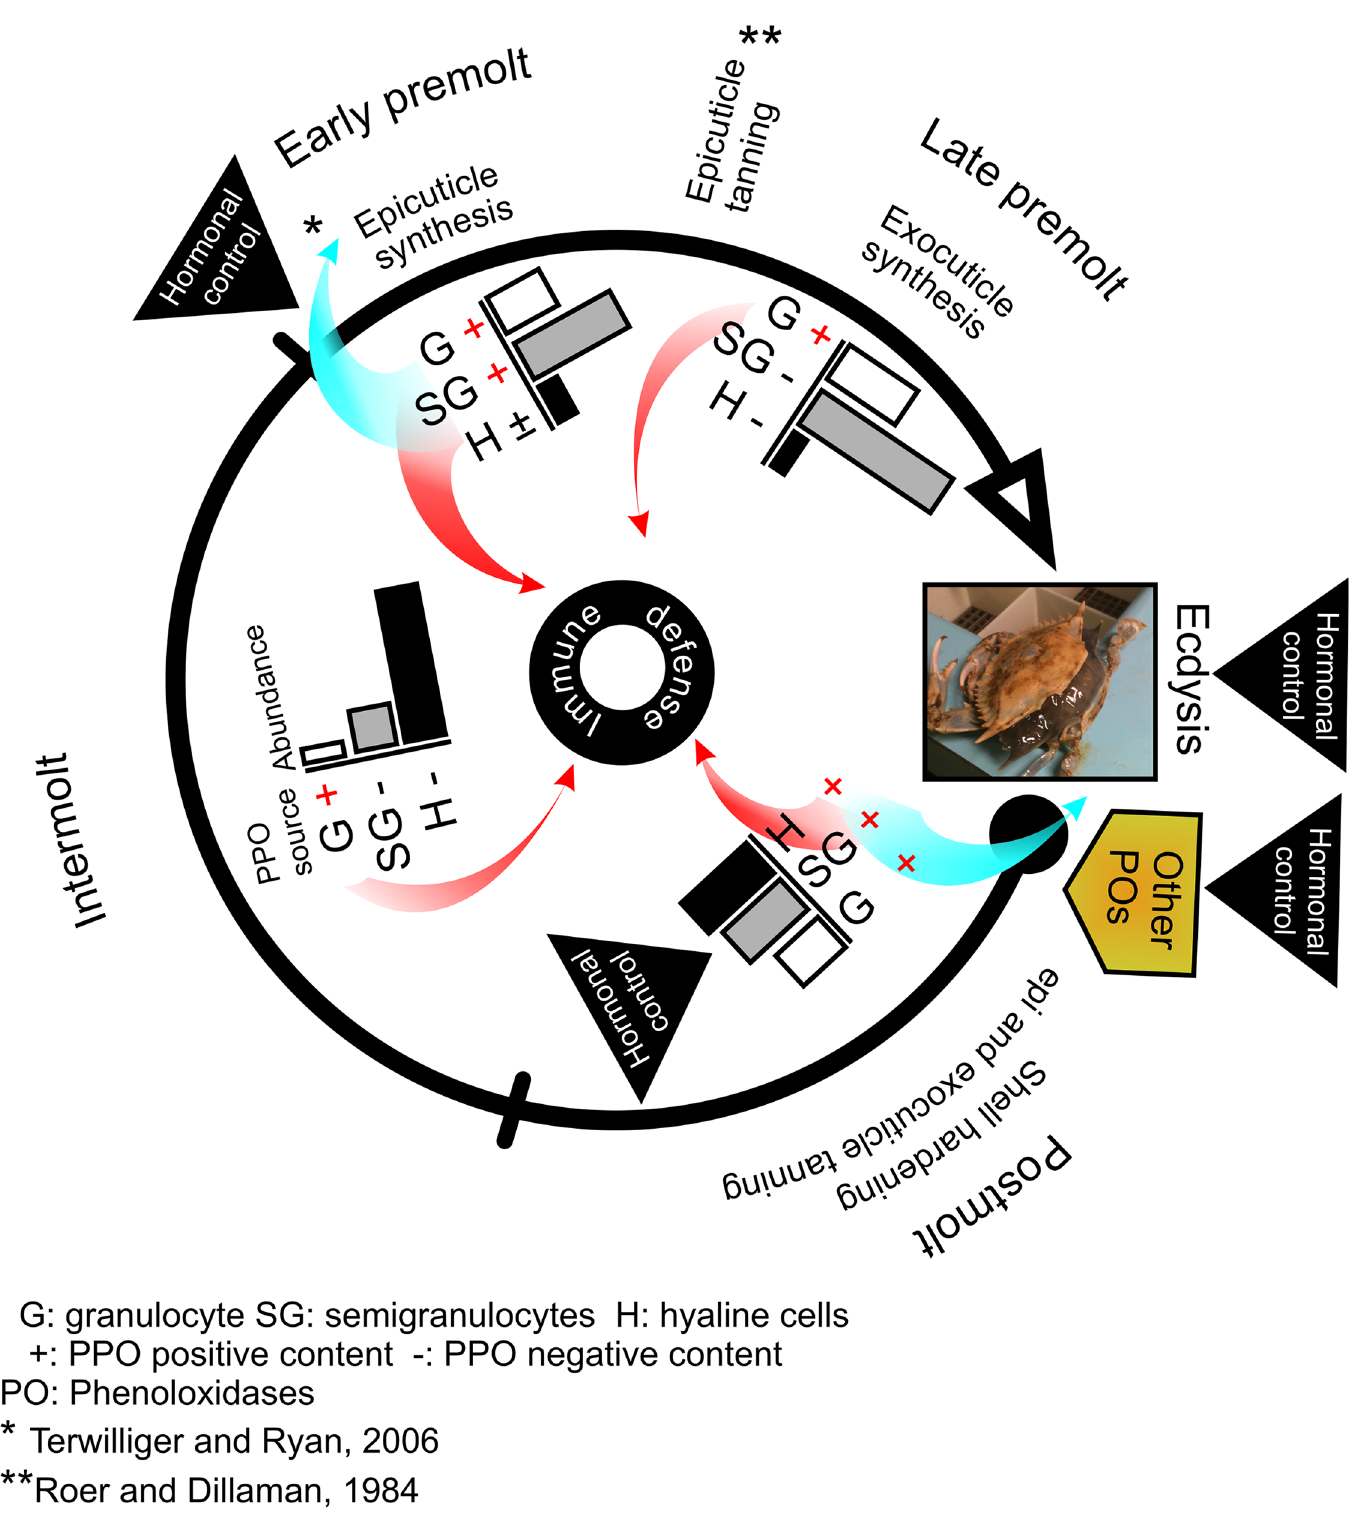
Fig 6. A proposed model for the involvement of hemocytes and its PPO (CasPPO-hemo) in the shell-hardening process of the blue crab, C . sapidus . The diagram summarizes the results obtained from the current study. Changes in hemocyte numbers are shown with bar plots. The positive (+) and negative (-) symbols indicate the presence or absence of PPO expression in each type of hemocytes, respectively. Blue arrows indicate the